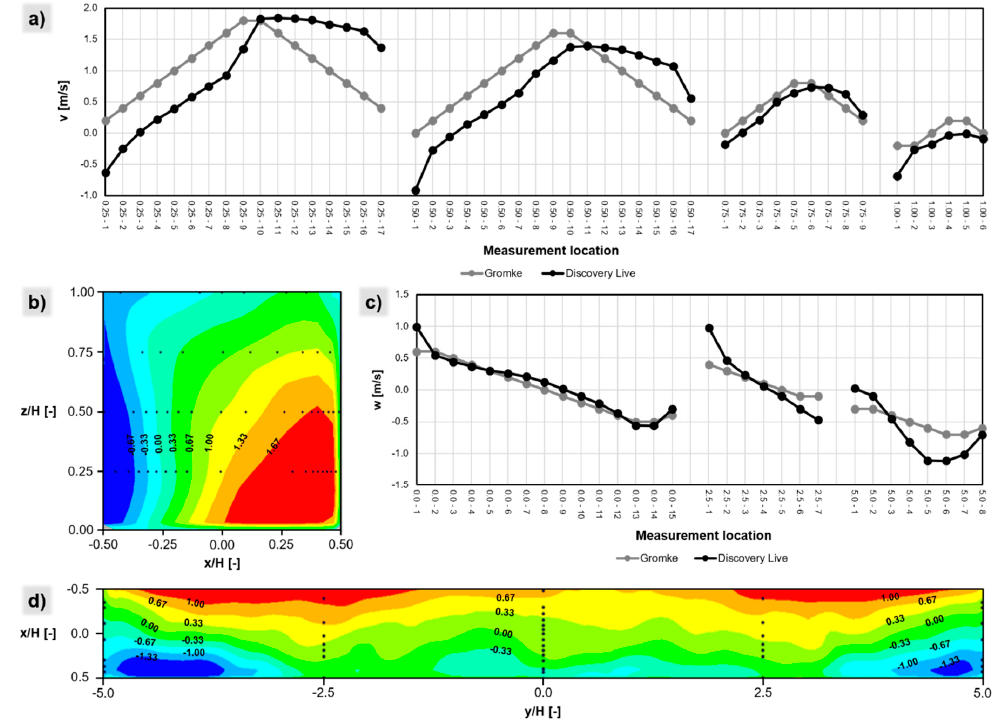
Figure 10. Visualization and comparison of time-averaged velocity component results from the wind tunnel measurement of Gromke and Ruck [9], and the Discovery Live simulation data. ( a , b ) show the inflow (+) and outflow ( − ) at the lateral ends of the street canyon in y direction. ( c , d ) show the upwards (+) and downwards ( − ) flow at roof level in z direction. The measurement locations are indicated with black dots.